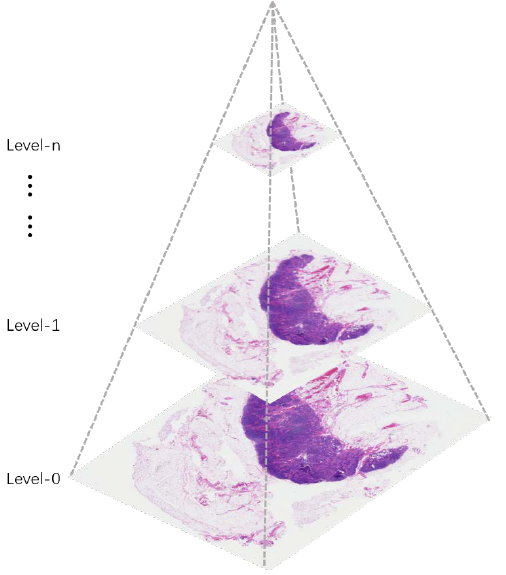
Figure 5. The multi-resolution pyramid structure of the whole-slide